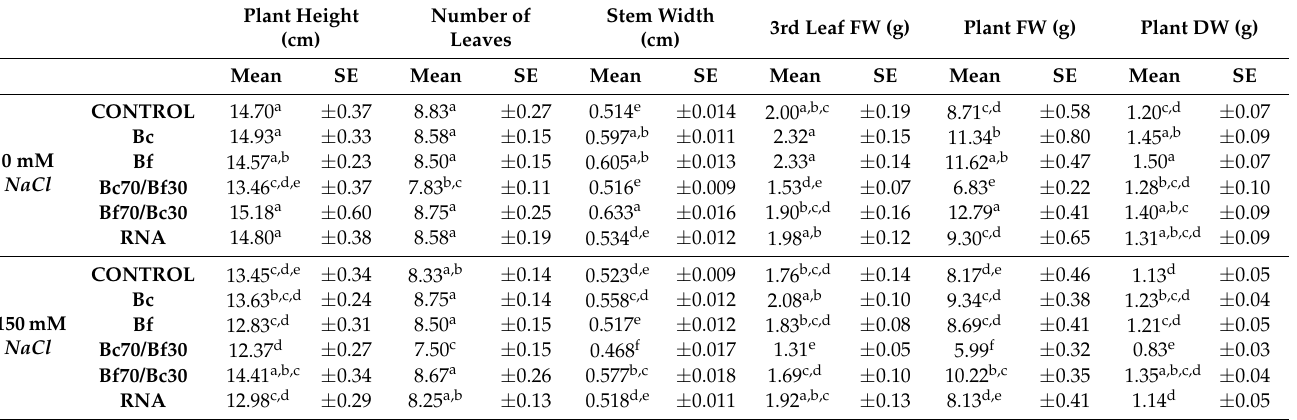
Table 1. Effect of biostimulant treatments on plant growth in control (0 mM) and salt-stressed (150 mM) conditions. Plant parameters studied include plant height, number of leaves, stem width, 3rd leaf fresh weight, plant fresh, and dry weight. Data are means ± SE of three replications. Values with different letters in the same column are significantly different ( p < 0.05). Treatment abbreviations are explained in Figure 1. FW: fresh weight, DW: dry